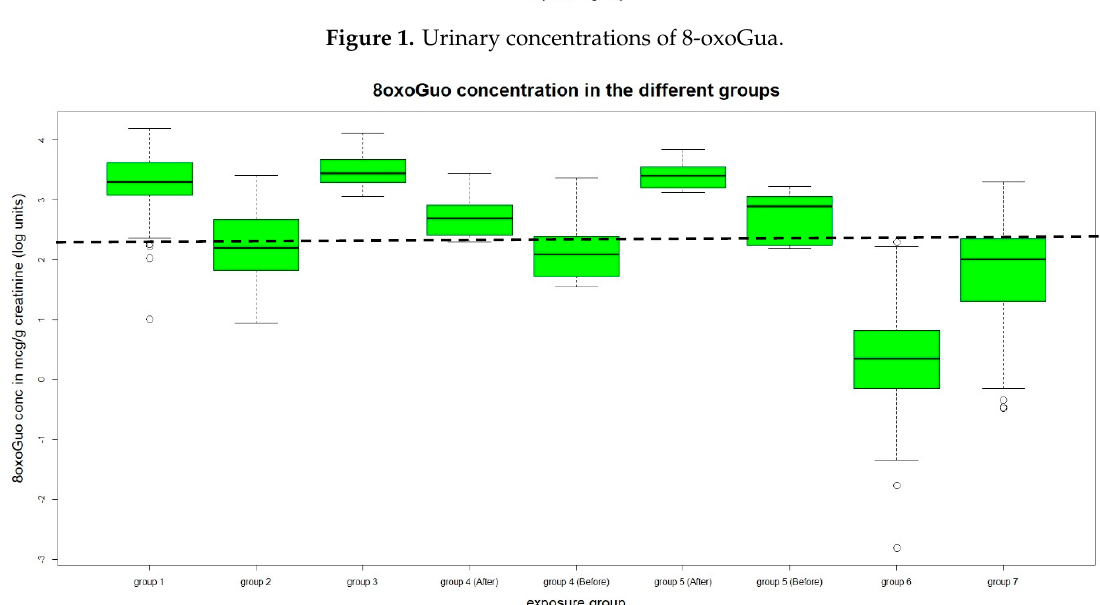
Figure 2. Urinary concentrations of 8-oxoGuo.